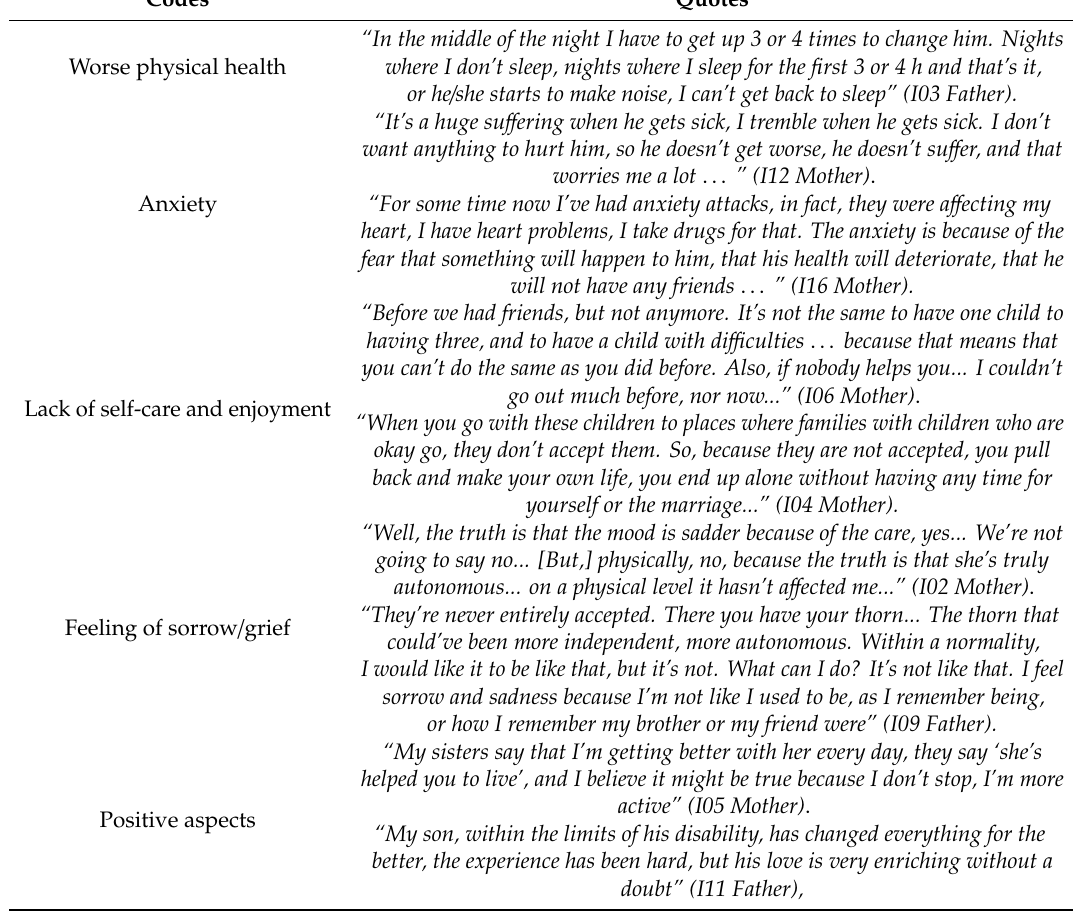
Table 4. Main quotes associated with Theme 3: Physical and emotional well-being as a